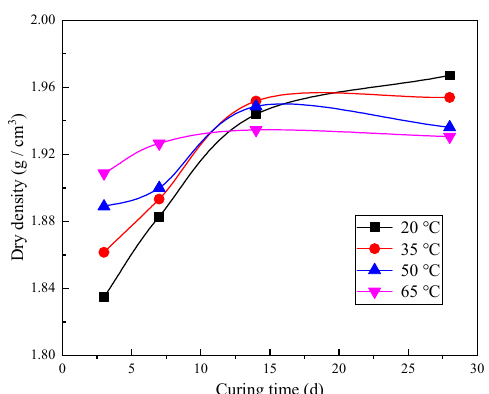
Figure 3. The change in dry density with time at different temperatures.